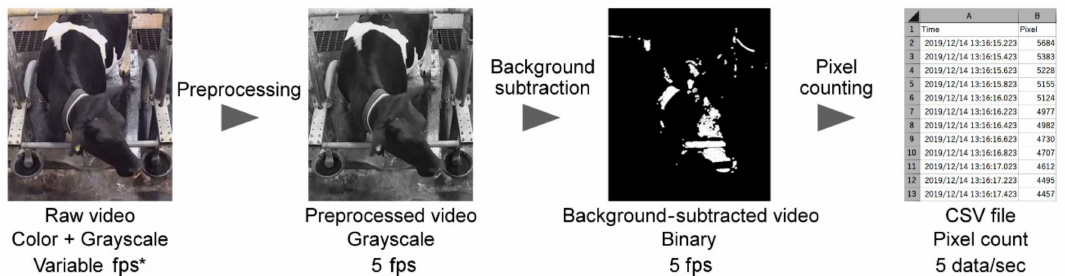
Figure 2. Video data analysis workflow. In the preprocessing step, all videos were converted to grayscale at a constant frame rate (5 fps). In the background subtraction step, the foreground (white pixels: moving objects) was extracted from each frame using the k-nearest neighbor-based background/foreground segmentation algorithm with the morphological opening operator. In the pixel-counting step, foreground pixels in a region of interest were counted at every frame. * Frames per